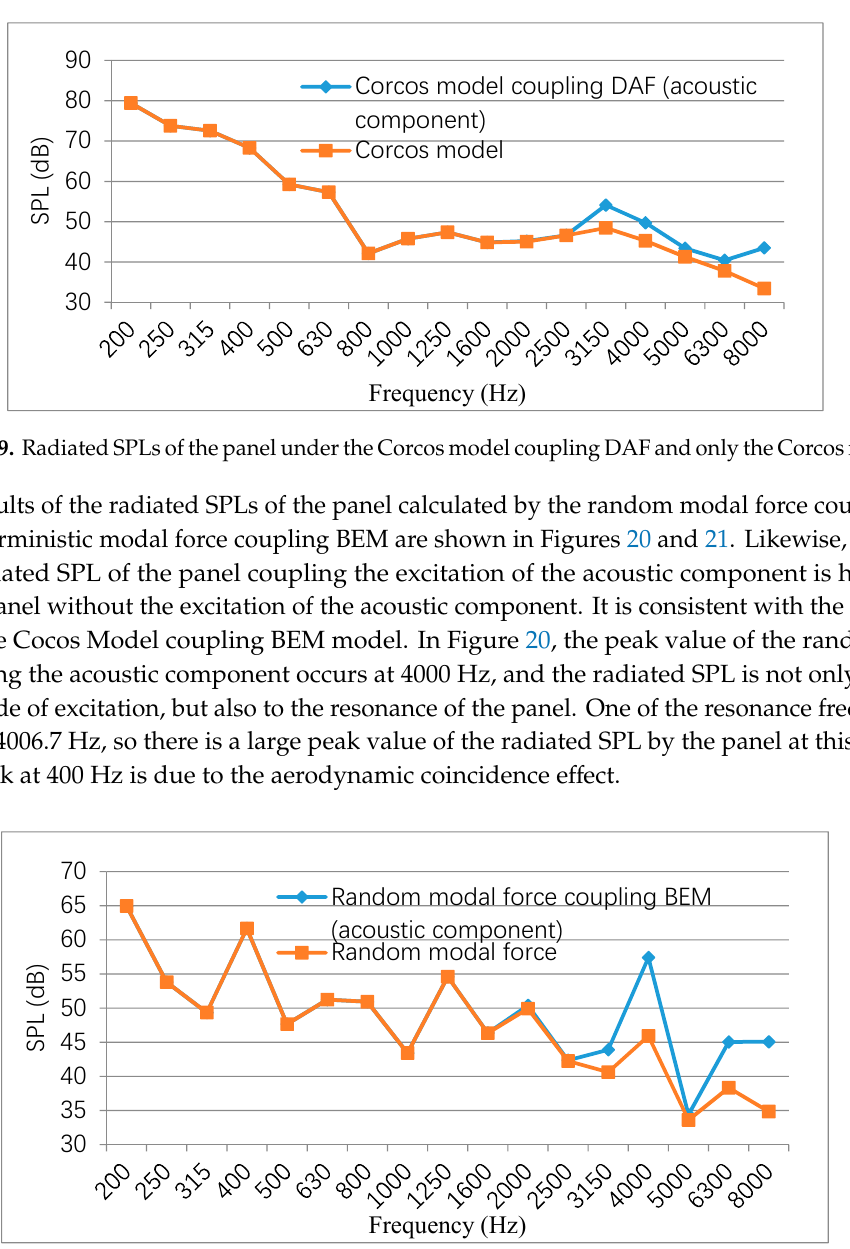
Figure 20. Radiated SPLs of the panel under the random modal force with and without the acoustic component.